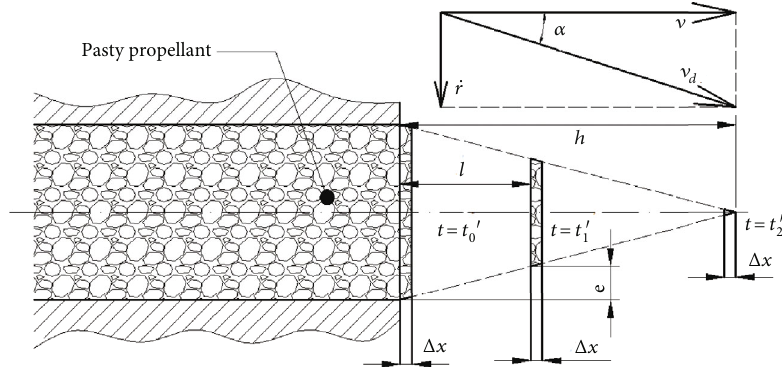
Figure 1: The selected grain change process of pasty